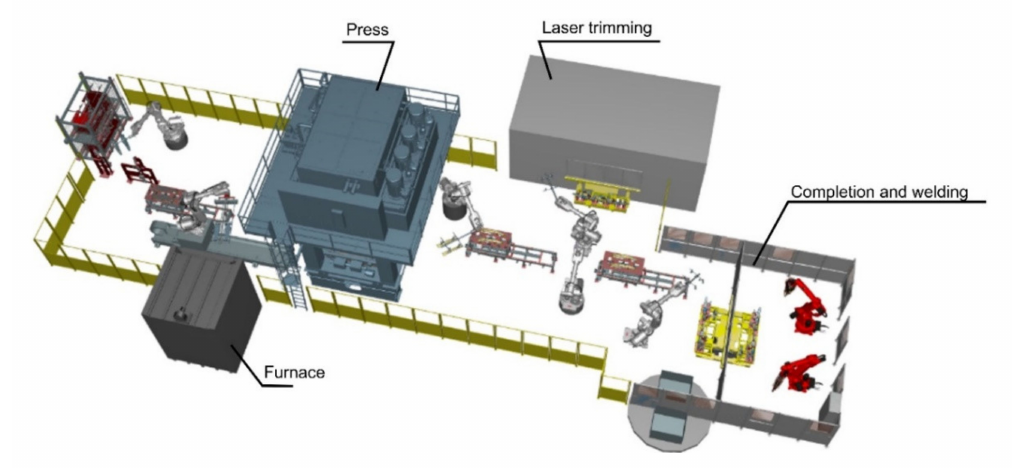
Figure 3. Digital model of the module for hot-stamping